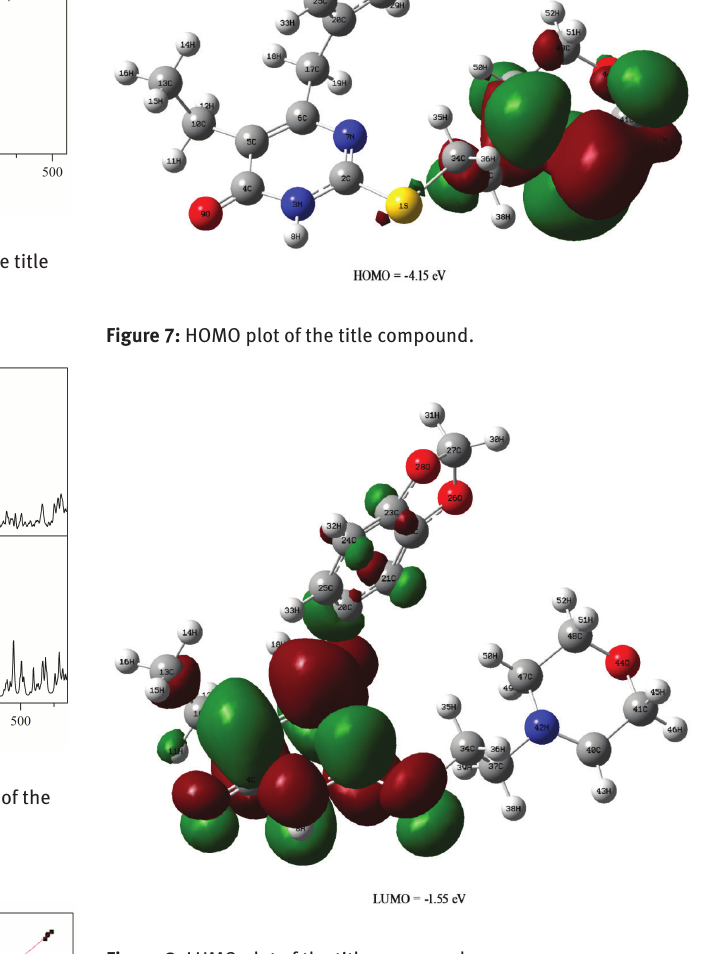
Figure 8: LUMO plot of the title